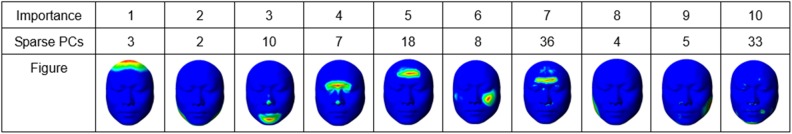
The proportion of each component in all craniofacial comparison.